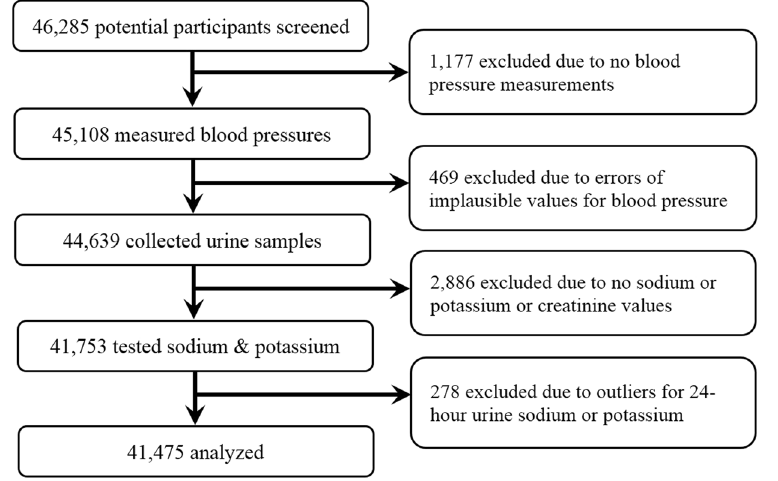
Figure 1. Flow chart of participant